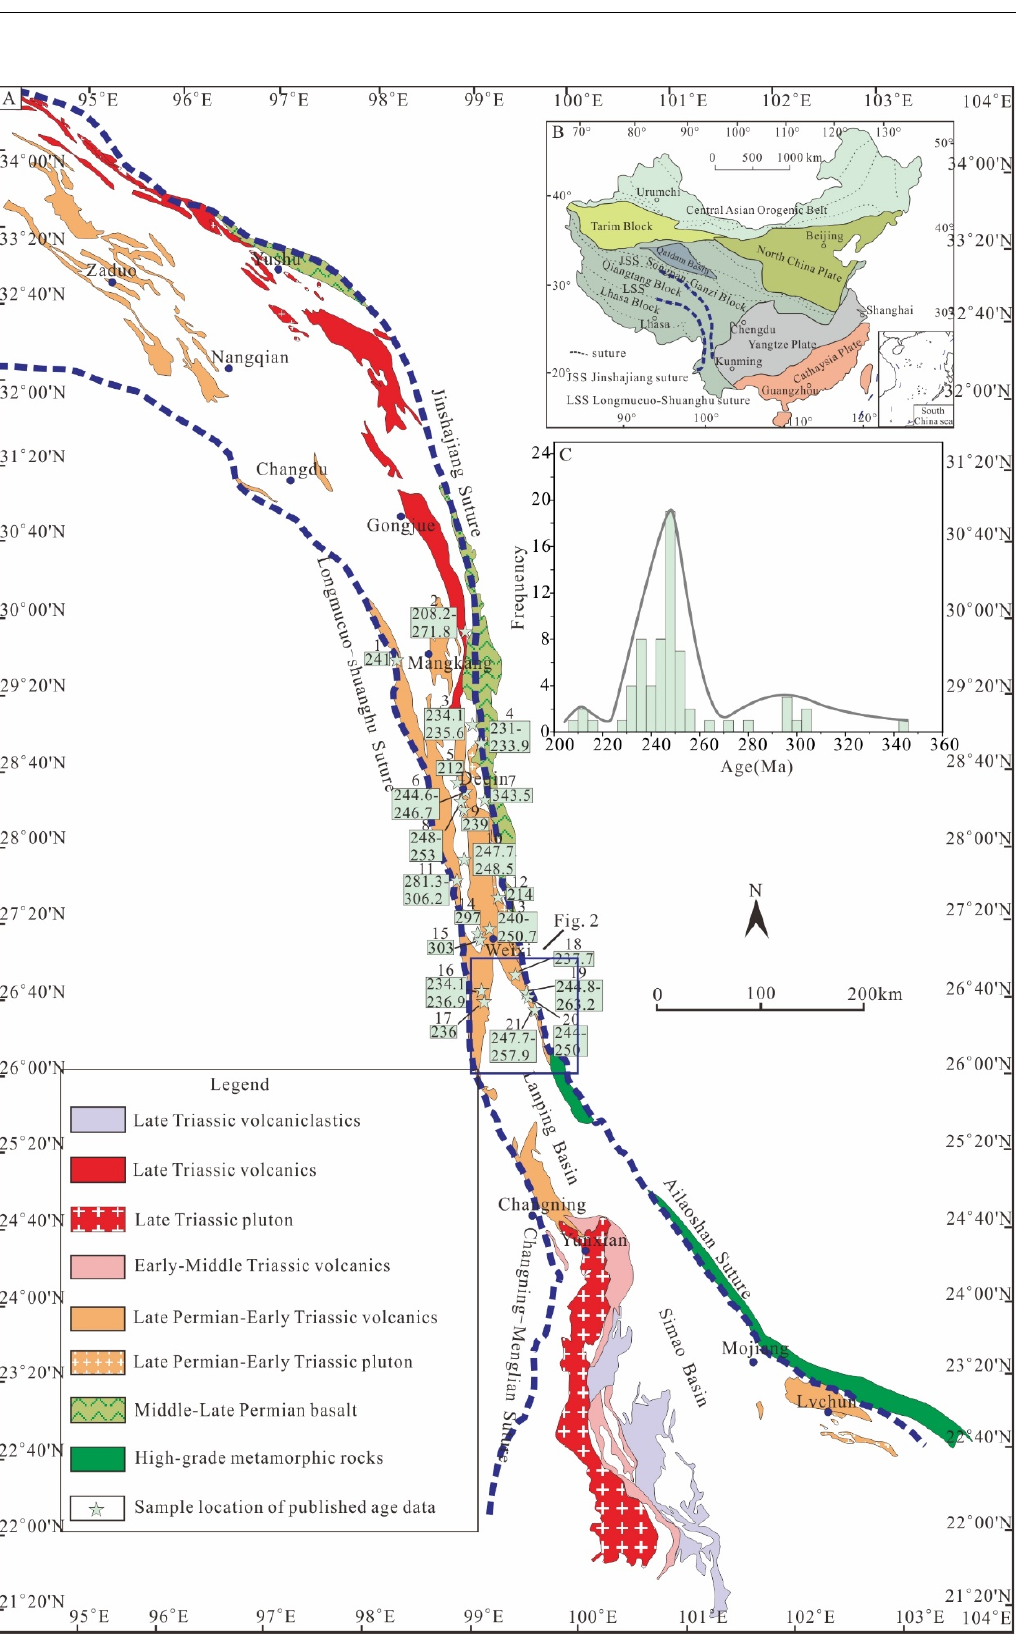
Figure 1. Simplified map showing the ( A ) spatial distribution of Paleo-Tethyan magmatic rocks in the Sanjiang Indosinian orogen (modified after [7]) (age data source listed in Table S1 (Supplementary Materials)), ( B ) tectonic location of the Sanjiang Indosinian orogen (modified after [21]), and ( C ) magmatic zircon age histogram for Deqin–Weixi–Madeng area.